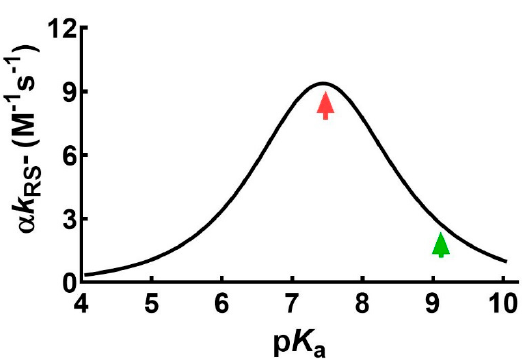
Figure 2. Dependence of the second-order kinetic constants ( α k RS -) on p K a for the reaction of several thiols with different p K a with different disulfides at pH 7.4 (modified from Ref. [9]). The red arrow marks the maximum value of the bell-shaped graph. The p K a of the unperturbed protein cysteine is labelled with the green arrow. The maximum implement of reaction rate due to a lowered p K a was found to be 3 times.